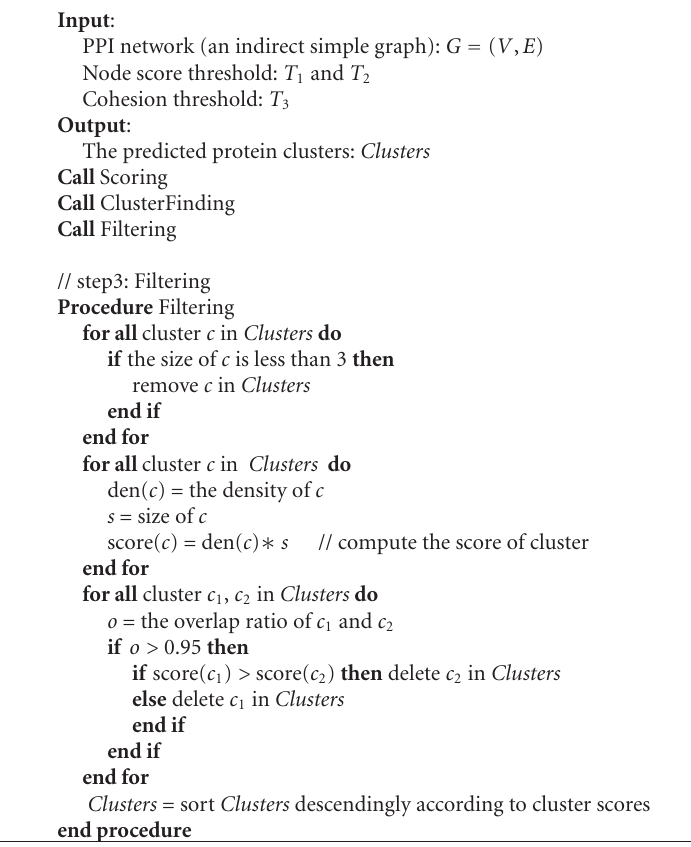
Pseudocode 3: Procedure